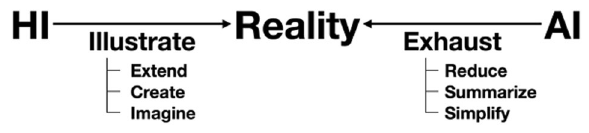
Fig. 1 Learning processes of AI and HI (Yu-cheng, 2020b, p. 122).